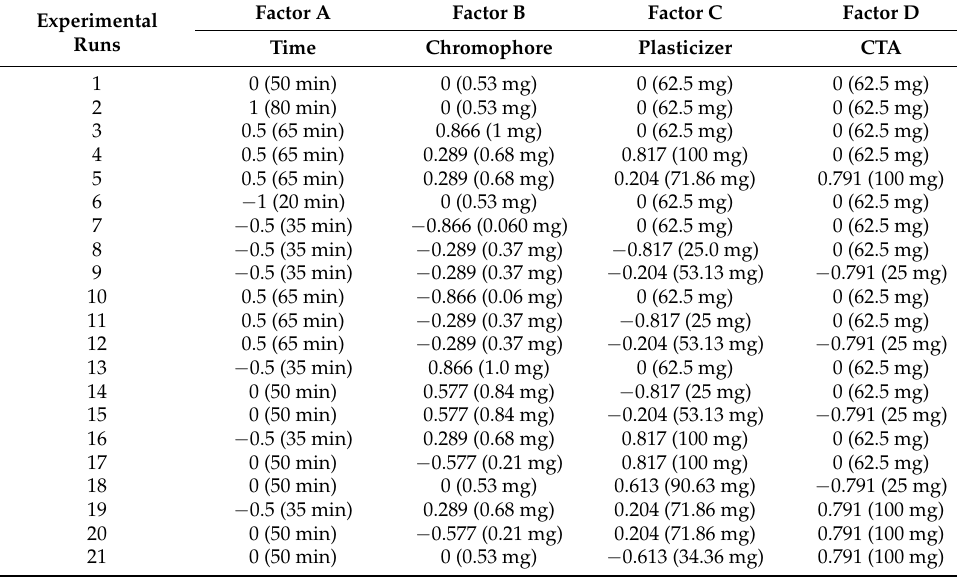
Table 1. Doehlert matrix employed to study the influence of the membrane composition and the equilibration time on the performance of the optodes. Coded and real values of the variables are